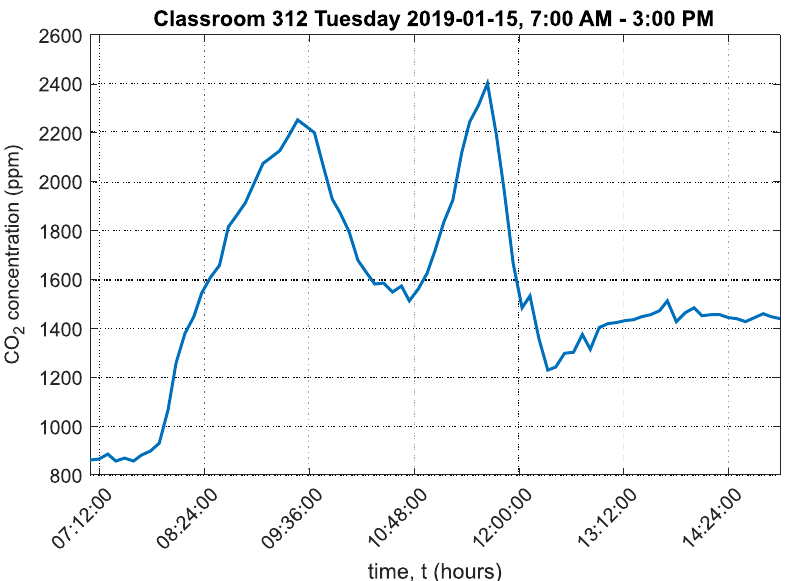
Figure 19. Graph of carbon dioxide concentration in classroom 312, Frenštát pod